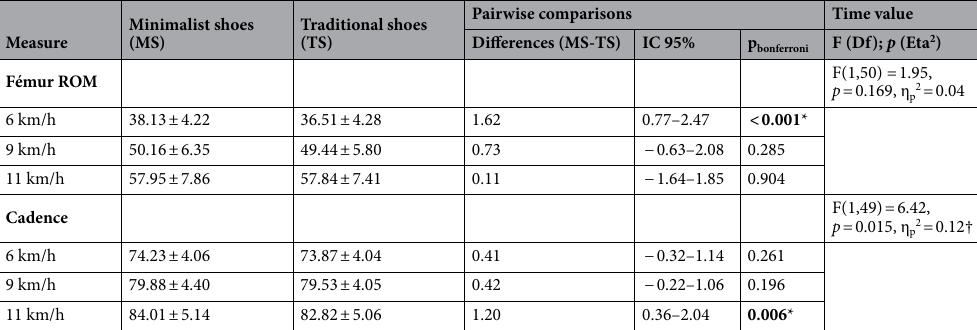
Table 2. Effects of shoes in biomechanical variables. *Bonferroni post-hoc test was used, †Greenhouse– Geisser correction was used. Significant values are in bold.